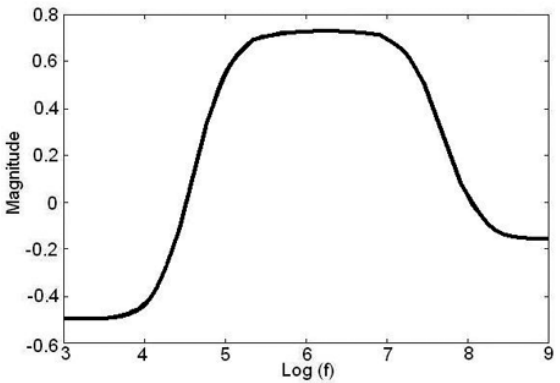
Fig. 8 – Magnitude of Re[F CM ] versus frequency for an E. coli of . 7, ε μ S m − 1 and σ . 5 S m − 1 , σ ε mem = 3 mem = 0 int = 50, int = 0 submersedinde-ionizedwaterof σ mem = 1 × 10 − 3 Sm − 1 . Moreover, d = 10 nm and r = 2 μ